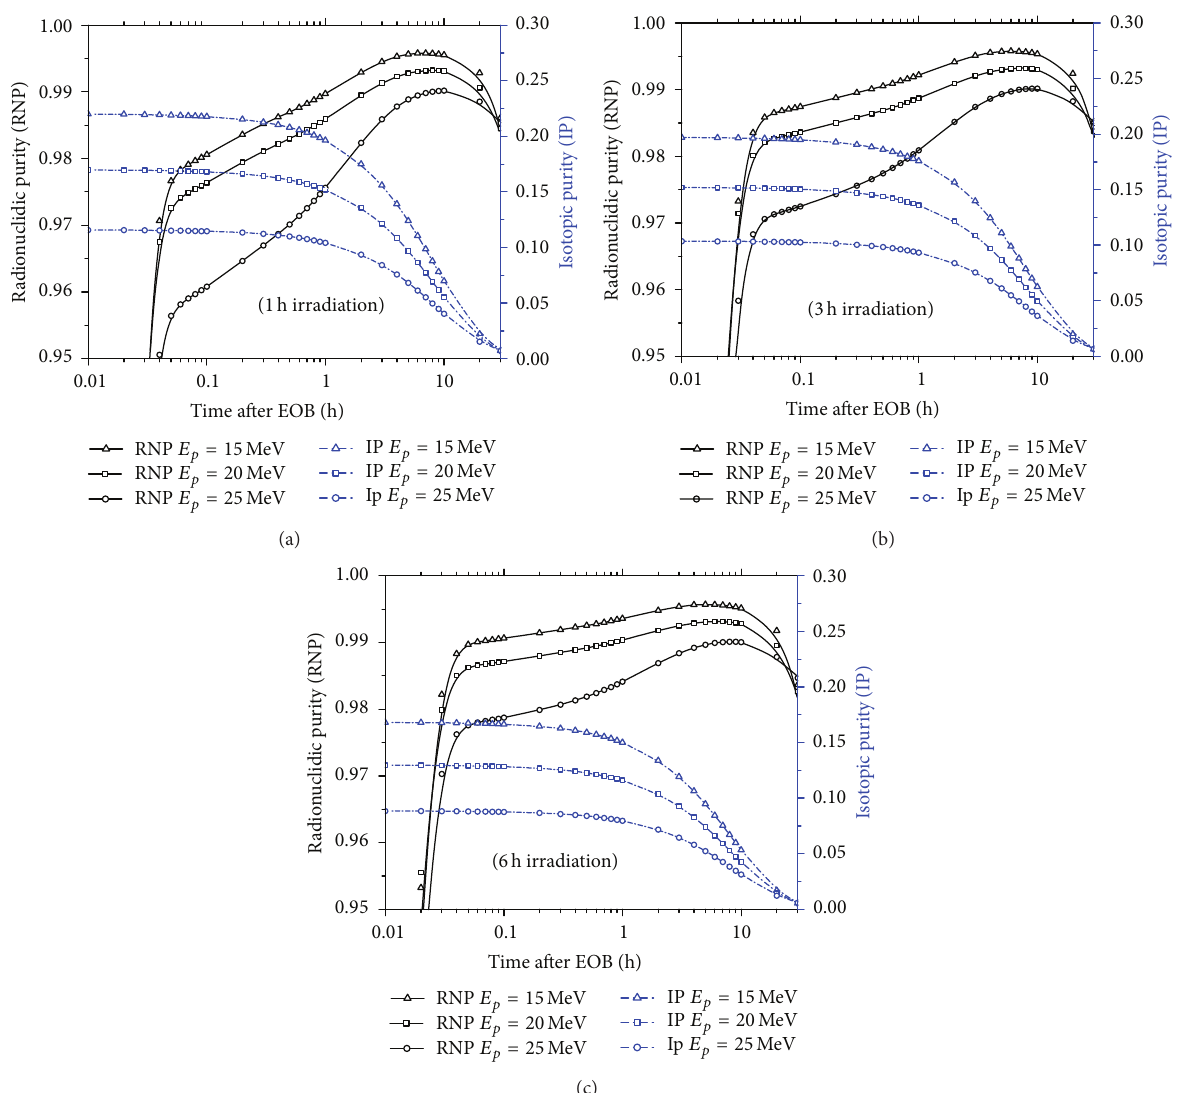
Figure8:Theevolutionof 99𝑚 Tcisotopicpurity(IP)andradionuclidicpurity(RNP)expectedinsidethetarget(orsupposingaquickchemical separation process of accelerator Tc produced) versus the decay time after EOB. 99.05% 100 Mo-enriched metallic molybdenum in optimized sample configuration bombarded at 15, 20, and 25MeV protons and 1, 3, and 6h irradiation times has been